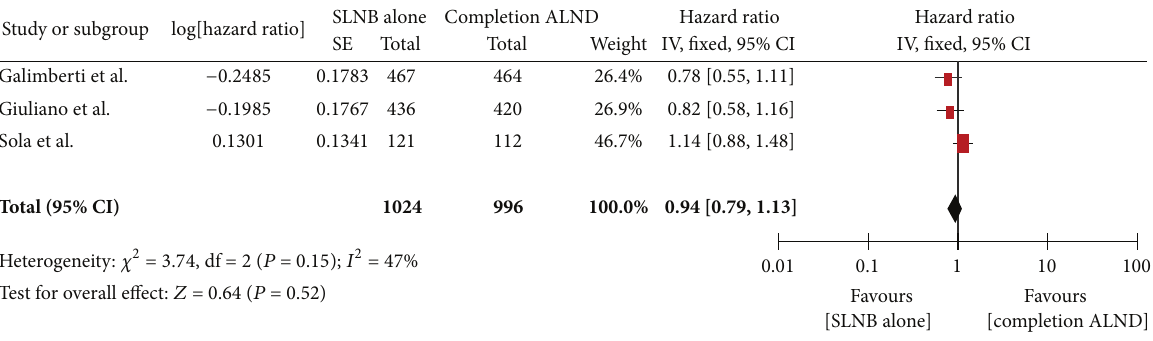
Study or subgroup Galimberti et al.